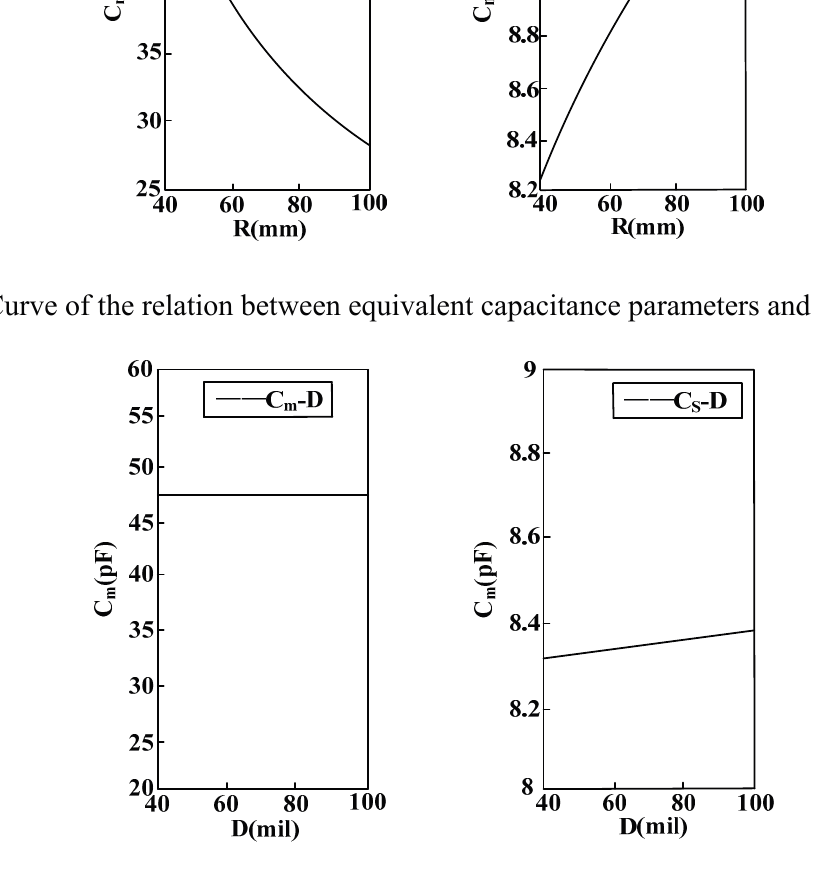
Figure 13. Curve of the relation between equivalent capacitance and electrode